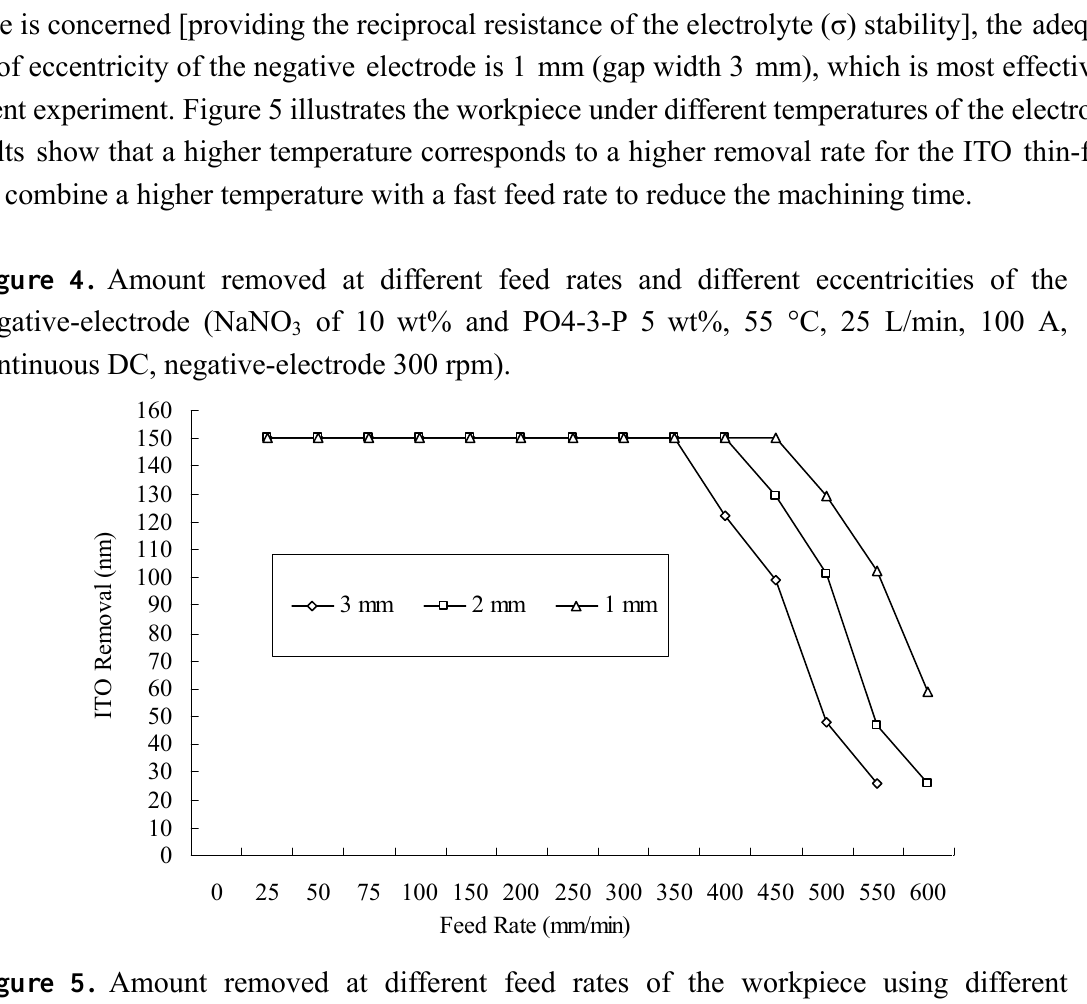
Figure 5. Amount removed at different feed rates of the workpiece using different temperatures of the electrolytes (NaNO of 10 wt% and PO4-3-P 5 wt%, 25 L/min, 150 A, 3 continuous DC, negative-electrode 300